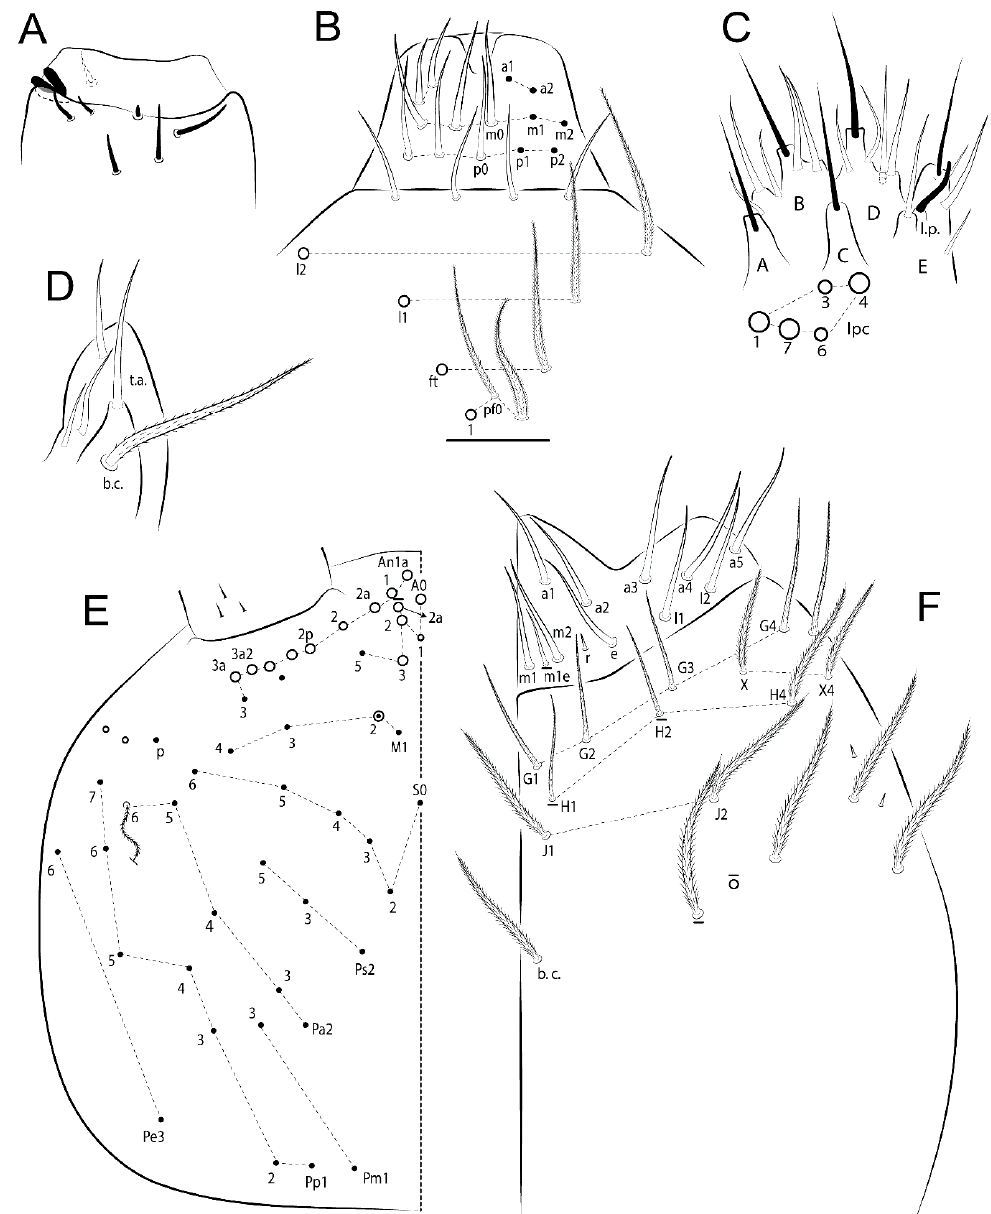
Figure 40. Pseudosinella aphelabiata sp. nov.: head. ( A ) Ant III apical organ (ventro-lateral view); ( B ) chaetotaxy of clypeus, prelabrum, and labrum; ( C ) labial papillae (H omitted) plus proximal chaetae; ( D ) maxillary palp and sublobal plate (right side), minute appendage omitted; ( E ) head dorsal chaetotaxy (left side); ( F ) basomedian and basolateral labial fields and complete postlabial chaetotaxy (right side).